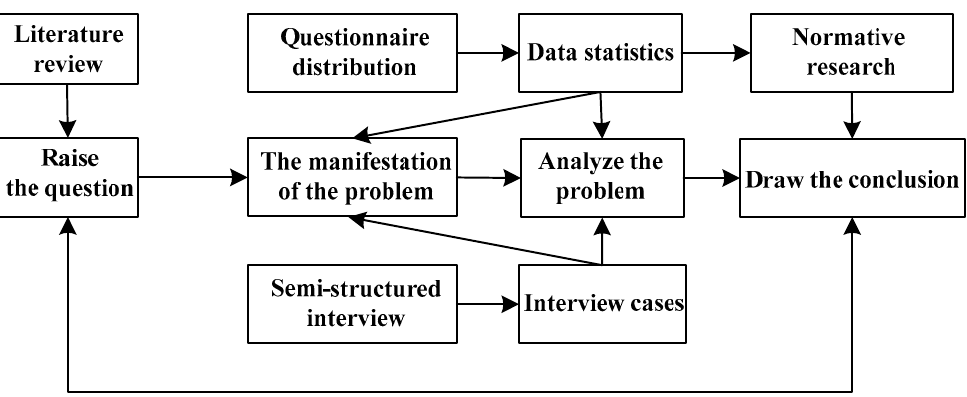
Figure 6. The methodology of this article.